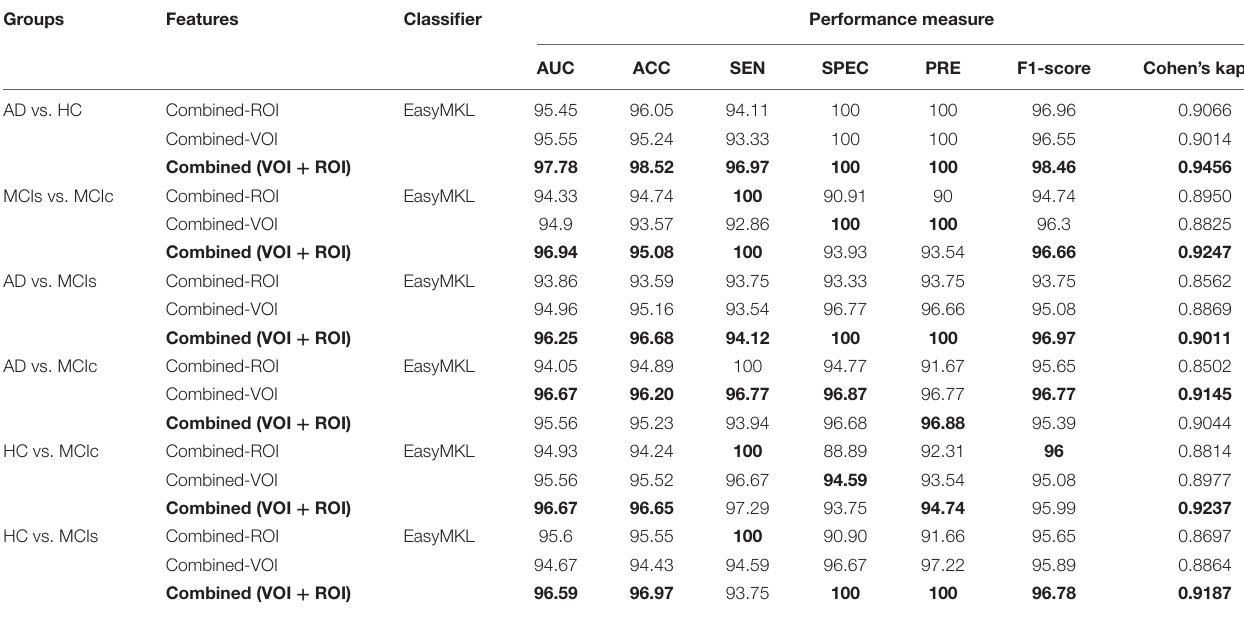
TABLE 4 | Classification result of AD vs. HC, MCIs vs. MCIc, AD vs. MCIs, AD vs. MCIc, HC vs. MCIc, and HC vs. MCIs groups using combined-(VOI + ROI) features, with both whole-brain and voxel-wise features (EasyMKL).